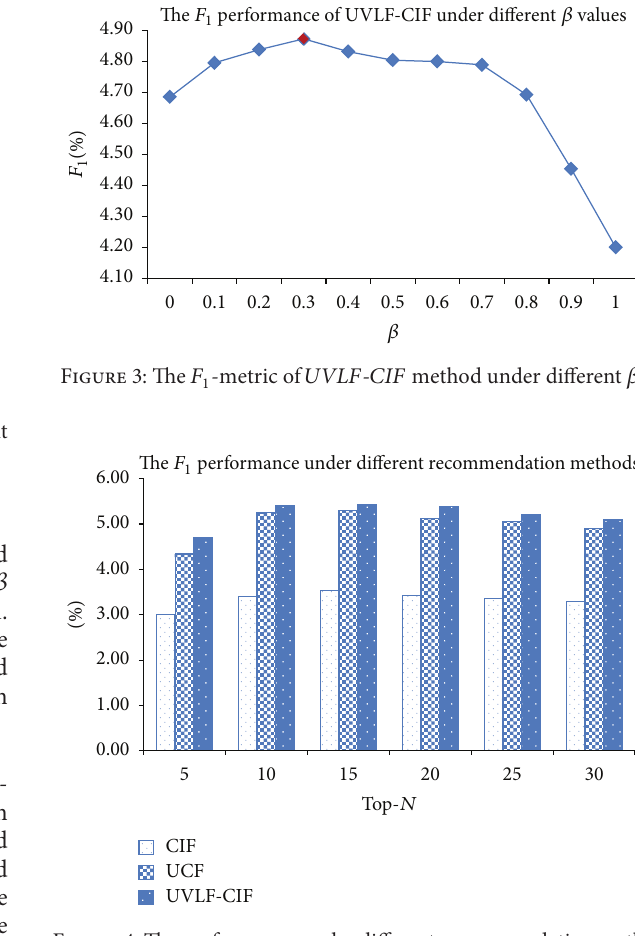
Figure 4: The performance under different recommendation meth-